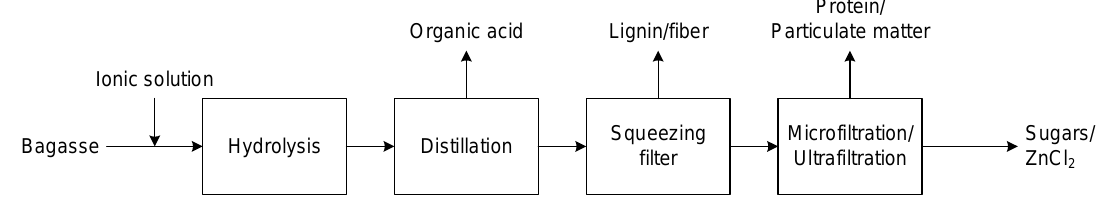
Figure 3. Bagasse hydrolysis and subsequent separation processes.